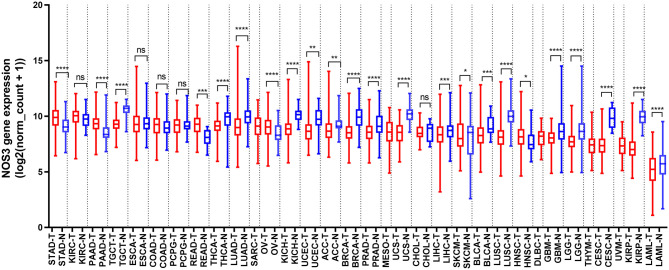
NOS3 mRNA expression in various normal tissues and tumors. NOS3 is differentially expressed between tumor and normal tissues in some cancers from TCGA and GTEx databases. Each boxplot represents NOS3 expression [RNA-seq RSEM, log2(normalized count +1)] across different cancers. Red is for tumors and blue is for normal tissues. The bar represents median expression of tumors or normal tissues and lower and upper box ends represent the 25th and 75th percentile expression. ns, without statistical significance, *p < 0.05, **p < 0.01, ***p < 0.001, ****p < 0.0001, based on Student's t-test.